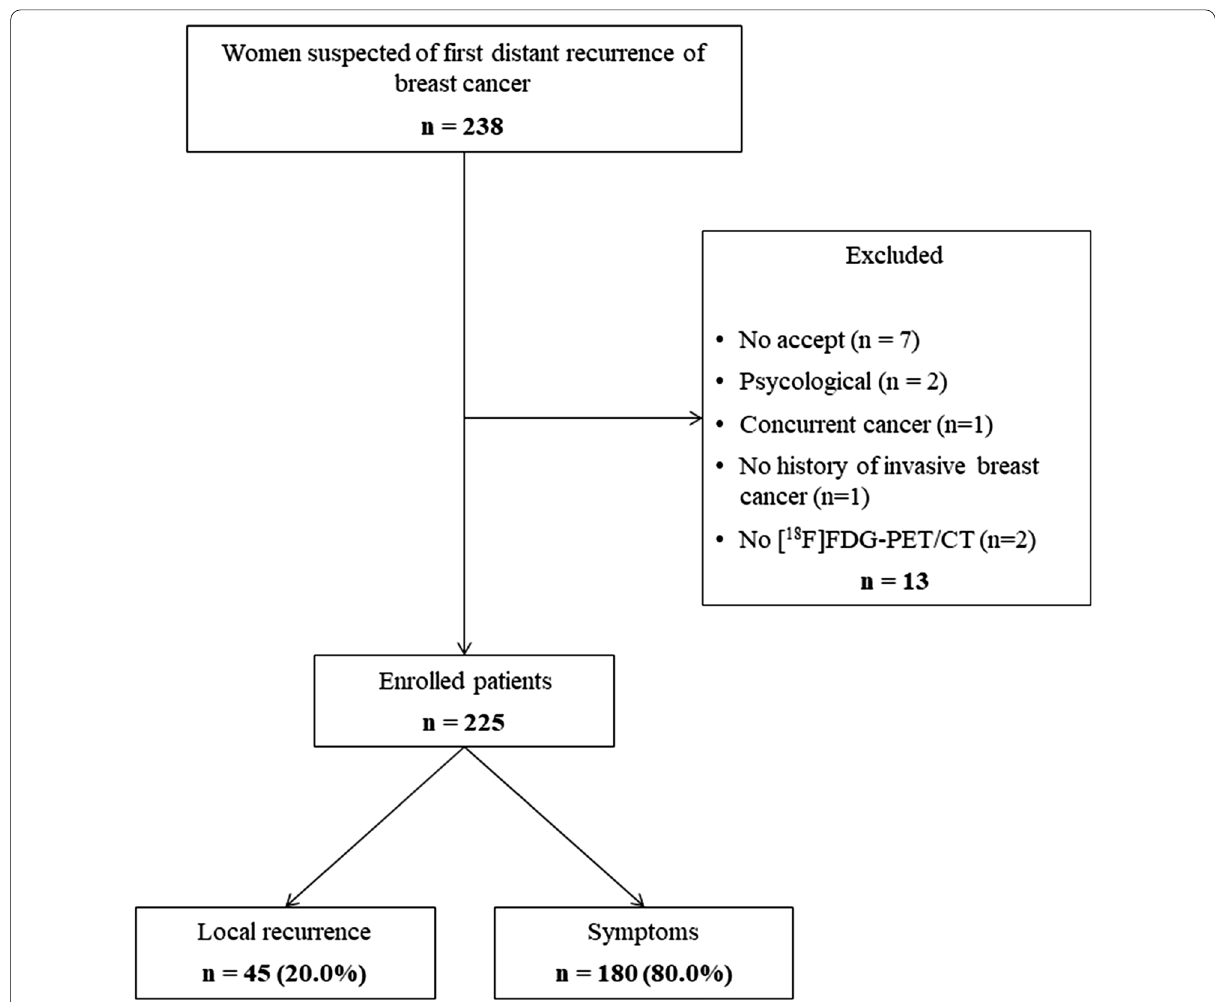
Fig. 1 Flowchart of 238 women referred for [ 18 F]FDG‑PET/CT due to suspicion of first distant recurrent breast cancer,